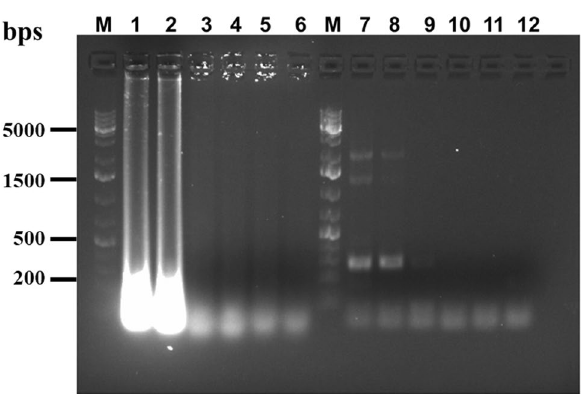
Figure 5. Comparative analysis between LAMP and regular PCR. Amplification was done using positive control and a suspected clinical sample by LAMP in lanes 1 and 2 and by PCR in Lanes 7 and 8, respectively. Others are negative controls viz . MTB control (Lanes 3 and 9), E.coli control (Lanes 4 and 10), no primer (Lanes 5 and 11) & no template (Lanes 6 and 12), Lanes L and M are